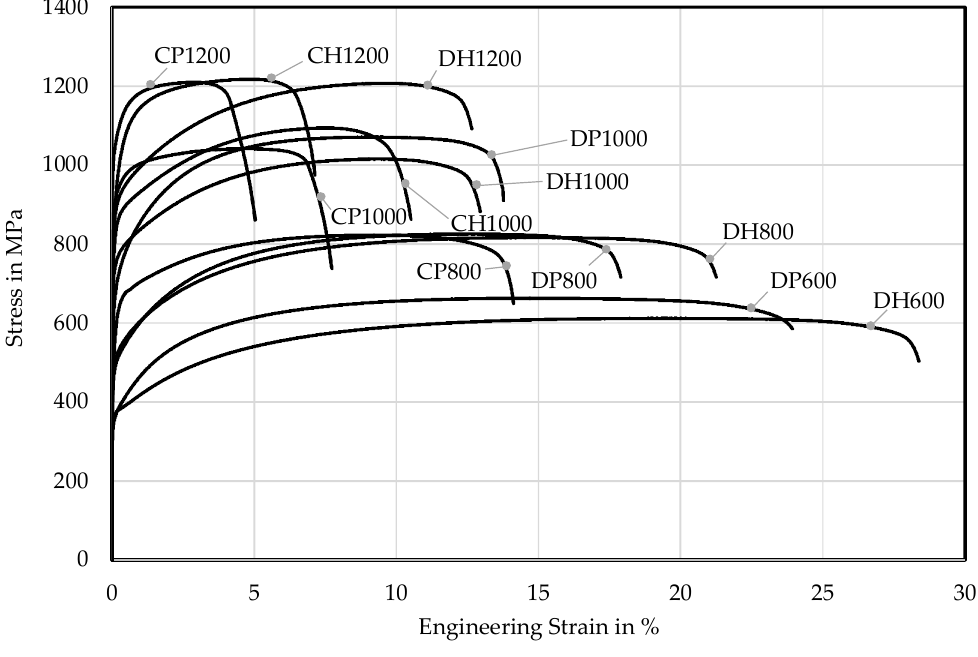
Figure 3. Engineering stress-strain curves (LD) according to SEP 1240 [54]. Table 6. Bending angles according to VDA 238-100 (failure criterion: 30 N load drop) [23].